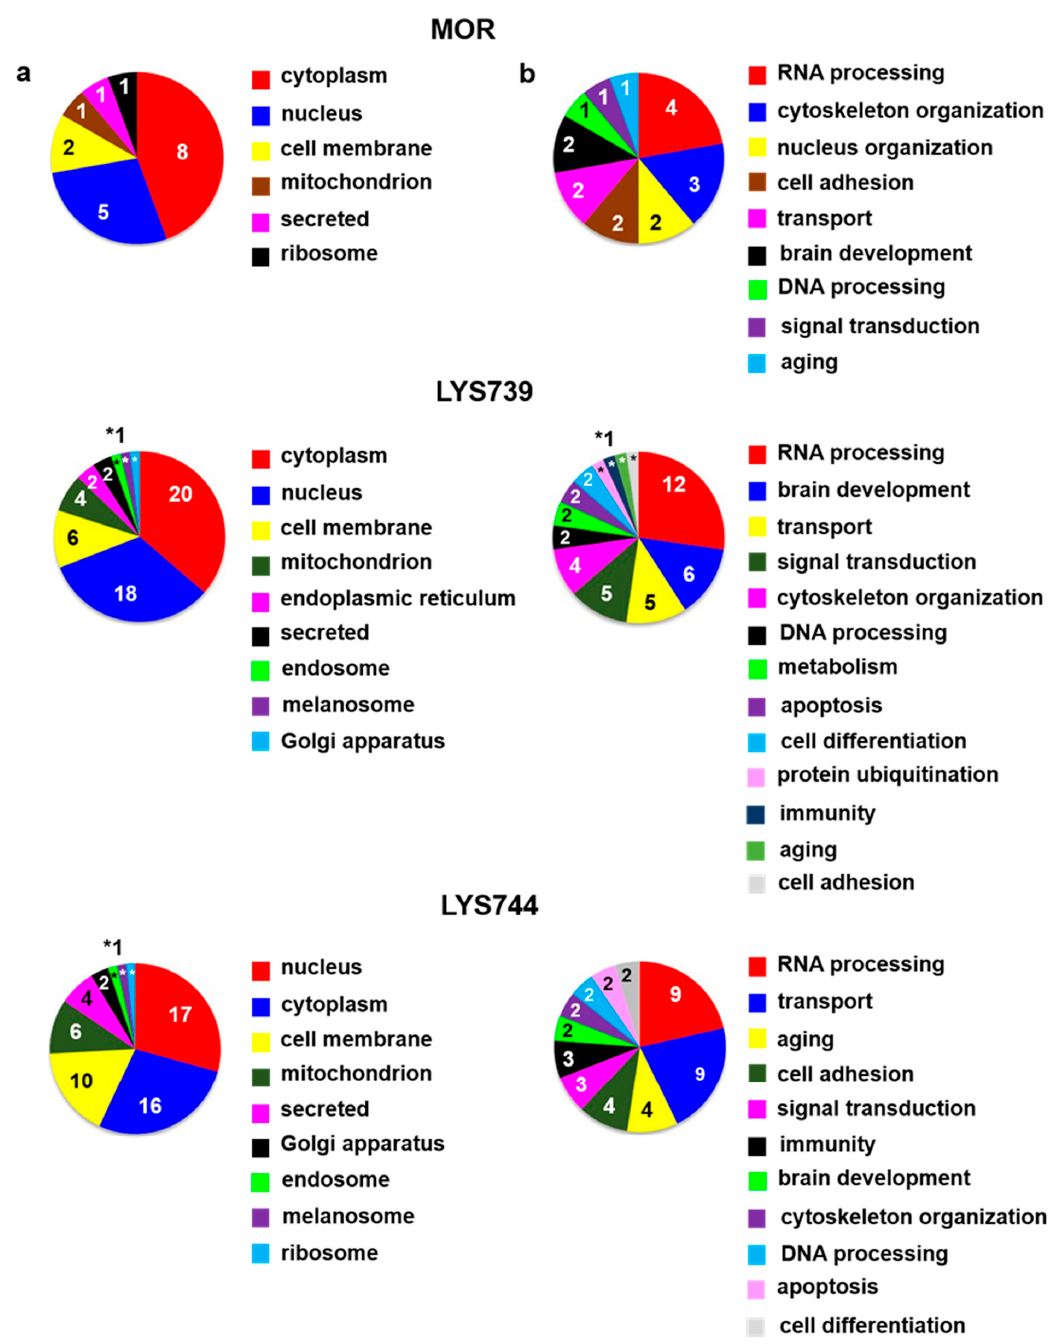
Figure 5. Subcellular localization ( a ) and function ( b ) of significantly altered proteins (at least 2-fold) identified in rat hippocampus after 7-day treatment with 3 mg/kg of morphine ( MOR , upper panels), LYS739 ( middle panels), and LYS744 ( lower panels); according to the current annotations in the Uniprot database (https://www.uniprot.org, accessed on 28 January 2022). The numbers represent proteins found within each subcellular localization and functional category, *1 .